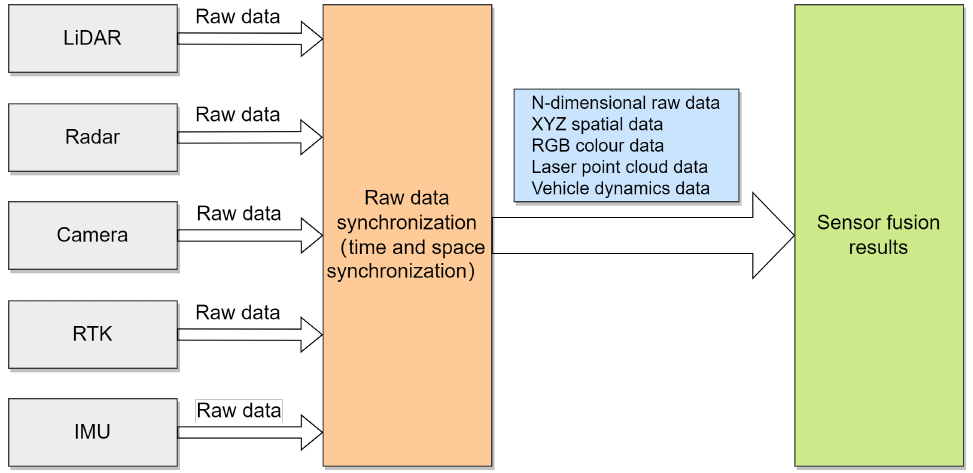
Figure 4. Typical architecture of the early fusion